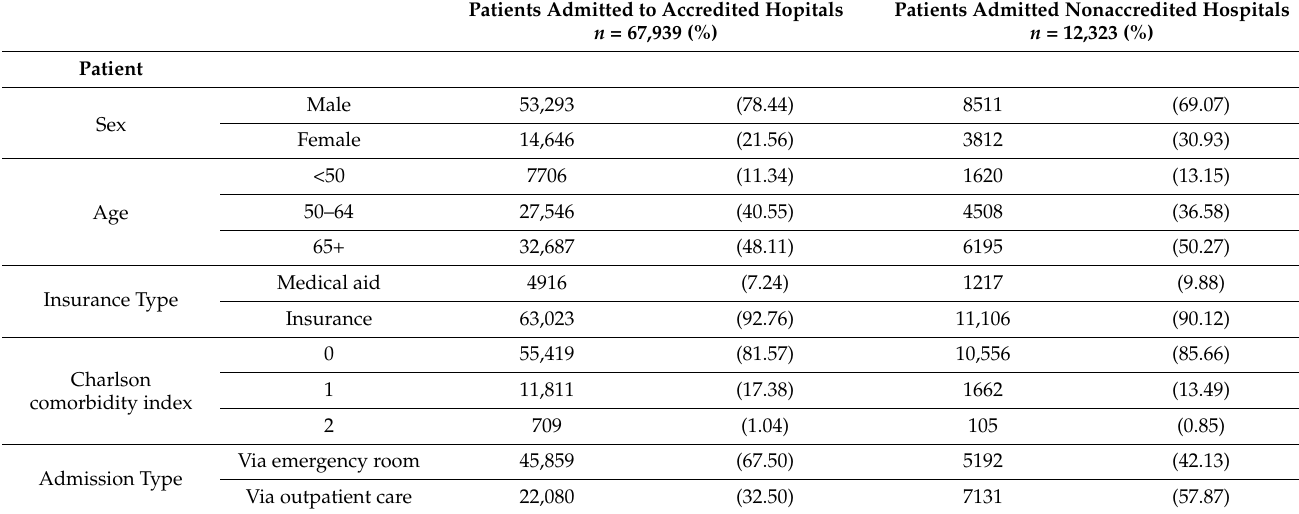
Table 2. General characteristics of study subjects according to hospital accreditation